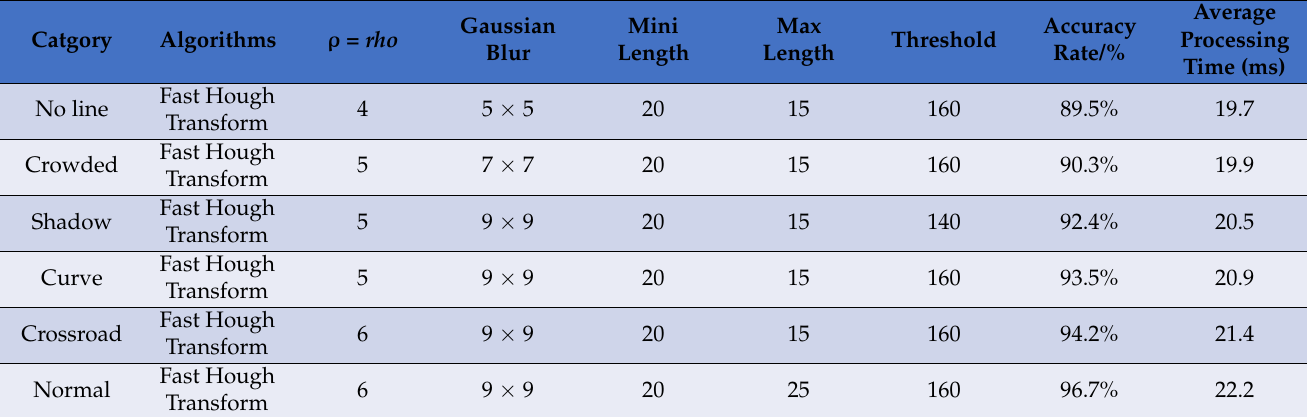
Table 2. Accuracy analysis of lane detection using the fast Hough